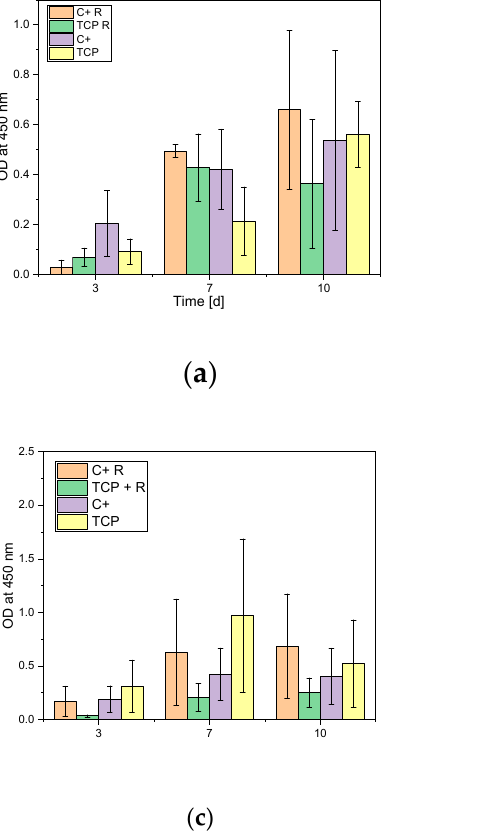
Figure 7. Differences in WST-I assay of MG-63 cells after cultivation on the different samples after a : 500; b : 750, and c : 1000; C + = Positive control / cells on Thermanox, TCP = Cells on sample, C + R = remaining cells in the control cell culture plate, TCP + R = Remaining cells in the TCP sample cell culture plate.